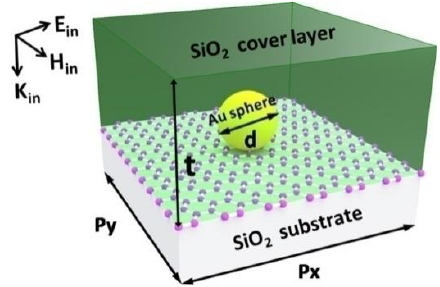
Figure 1. The unit cell of the investigated structure to enhance the light absorption of graphene monolayer.